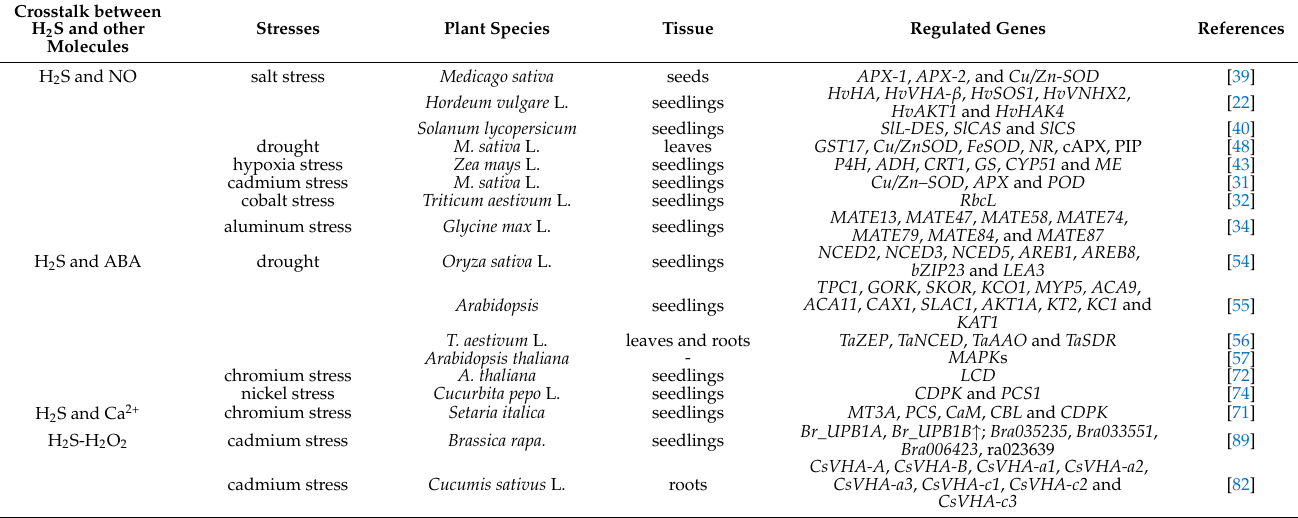
Table 1. Genes regulated by H 2 S and other molecules under abiotic stress